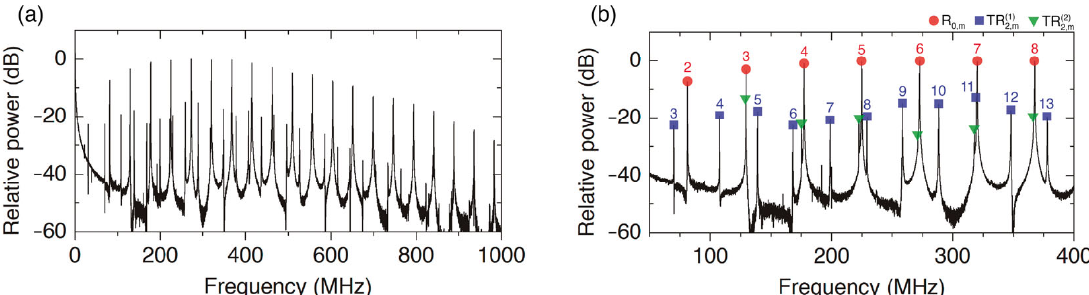
Figure 4. ( a ) Spectrum of transverse acoustic resonances with pump polarization adjusted for an optimum excitation of TR 2, m modes. ( b ) Detail of the strongest resonances with the identification of each resonance type: R 0, m modes are denoted by circles, while TR squares and triangles, respectively. Each resonance, R 0, m and TR